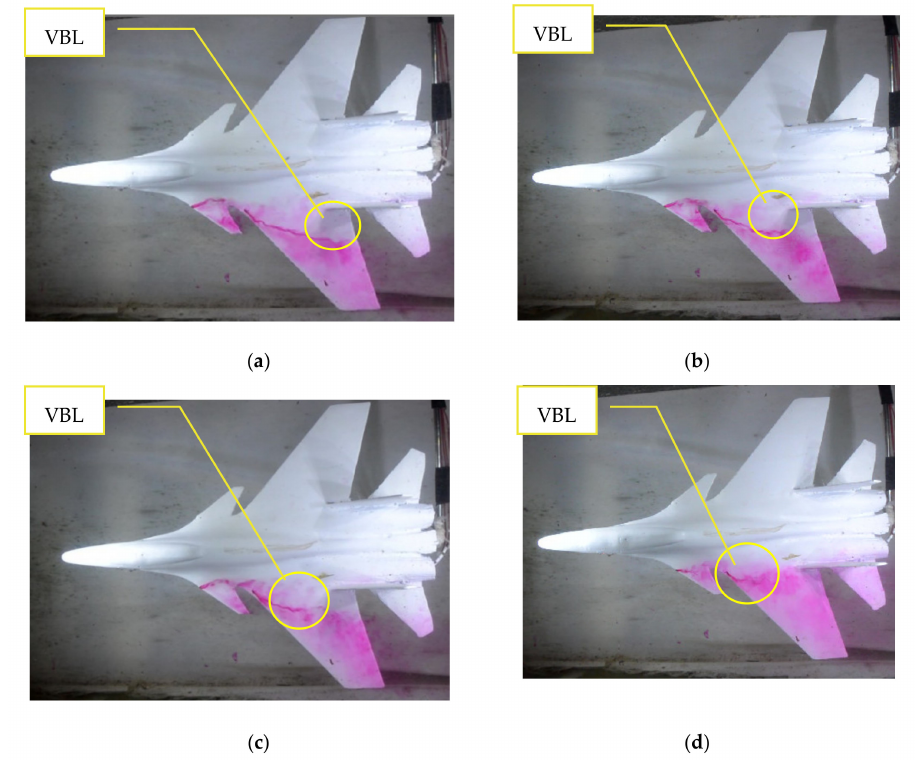
Figure 6. Water tunnel visualization and vortex breakdown location (VBL) on the SU-30; ( a ) AoA 20 ◦ ; ( b ) AoA 30 ◦ ; ( c ) AoA 40 ◦ ; ( d ) AoA 50 ◦